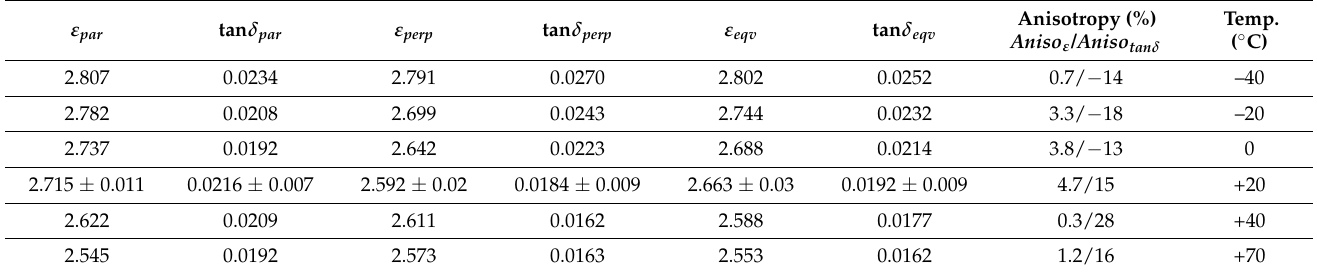
Table 5. Measured values of dielectric parameters of PDMS at different temperatures (parallel values—12.5 GHz; perpendicular values—7.5 GHz; equivalent values—10